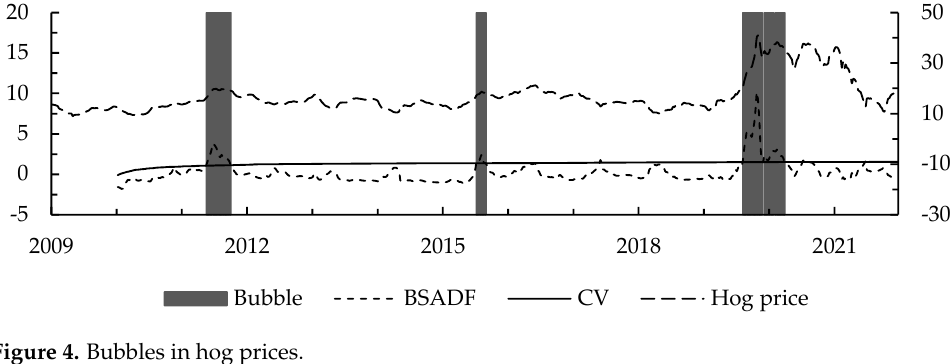
Figure 4. Bubbles in hog prices.